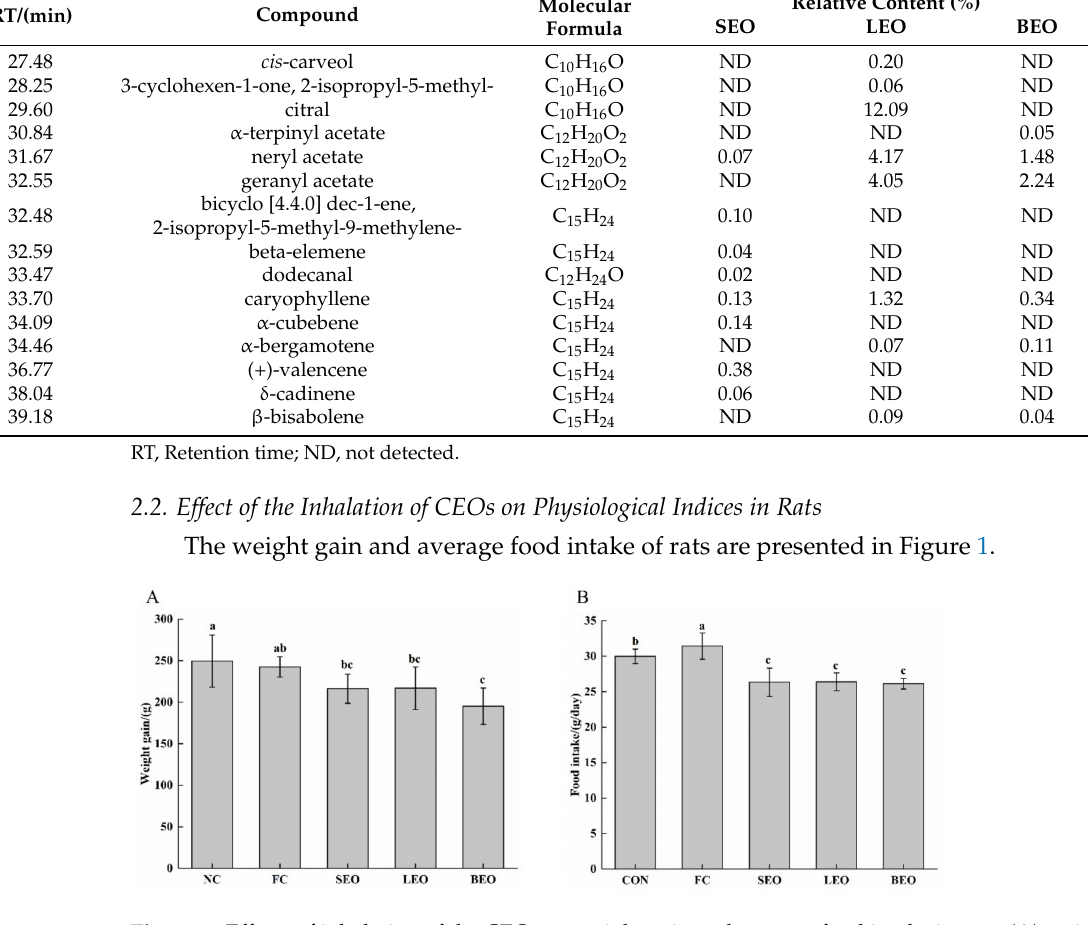
Figure 1. Effects of inhalation of the CEOs on weight gain and average food intake in rats. ( A ) weight gain, ( B ) average food intake. Data are the means ± SD. Different lowercase letters indicate significant differences, p <